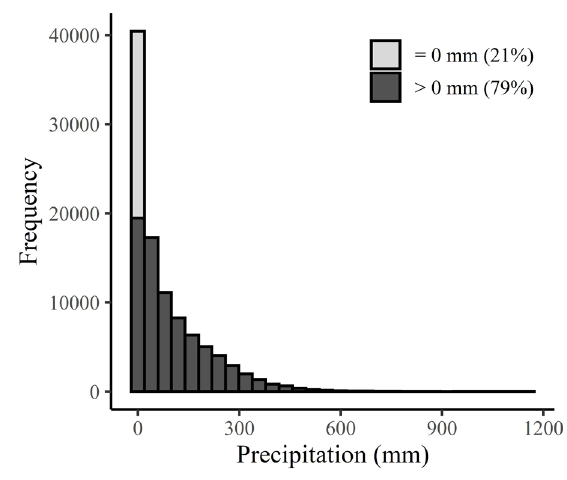
Figure 3. Histogram of precipitation. The colors in the figure represent the percentages of values equal to or greater than zero in the data